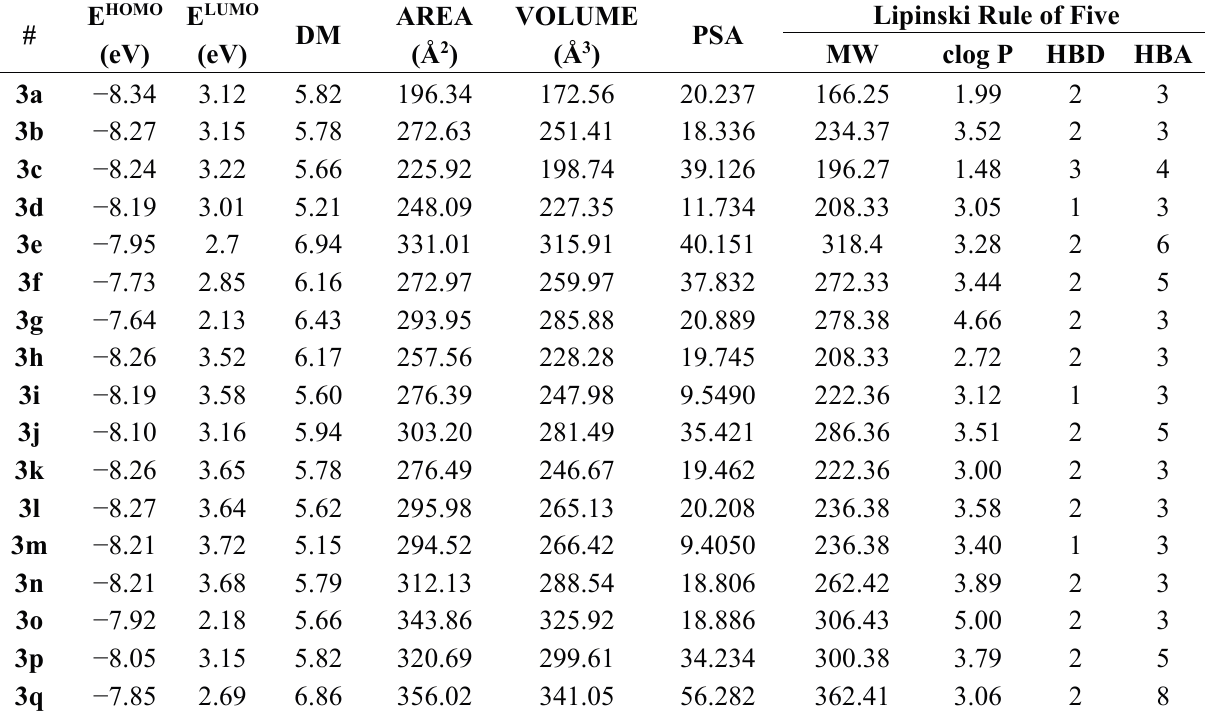
Table 4. The stereoelectronic properties of N,N' -disubstituted thioureas. DM =